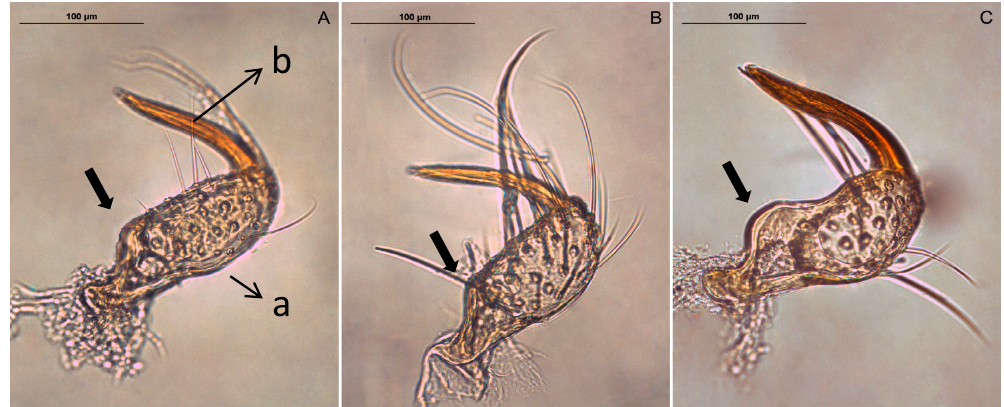
Figure 1. Dorsal view of the left paramere of M. pygmaeus ( A ), M. melanotoma ( B ) and M. costalis ( C ). Parts of the paramere: body with the sensory lobe (a) and apical process (b). The arrows show body shape differences between species.